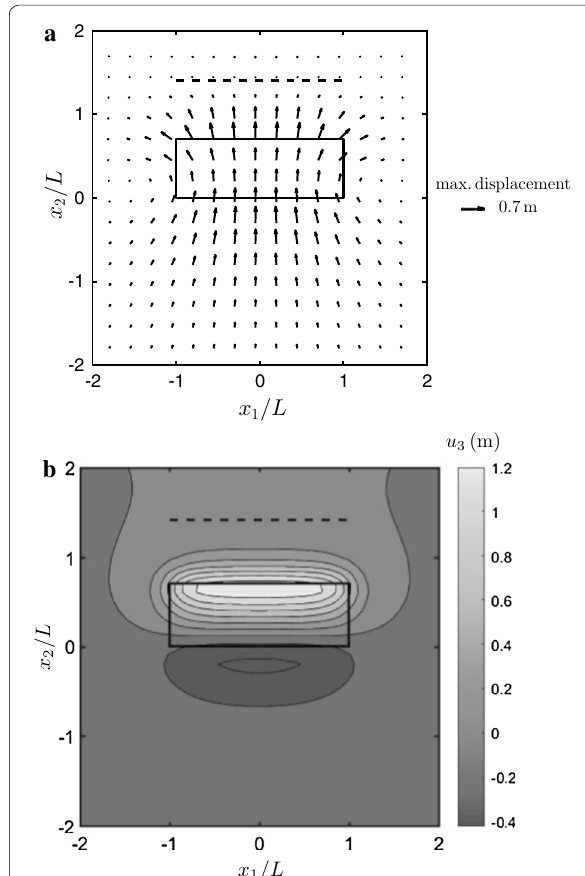
Fig. 10 Ground displacement produced by afterslip following the 2011 Tohoku-Oki earthquake, according to the model. a Horizontal component; b vertical component u 3 . The rectangle is the projec- tion of the weak fault region on the Earth’s surface, and the dashed segment is the fault trace. The x 1 and x 2 axes are parallel to the strike direction of the fault and to the direction normal to strike, respec- tively. Distances are measured in units of the half-side of the fault 200 along the strike direction, namely L =